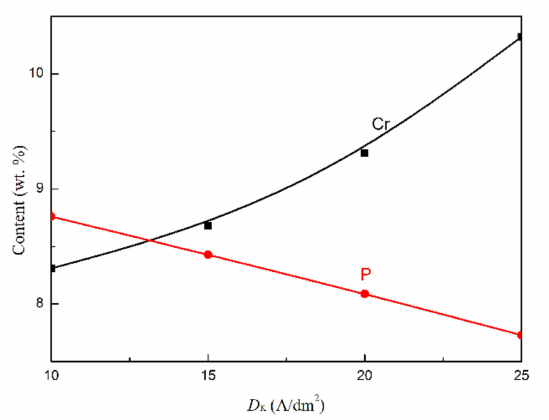
Figure 5. SEM images of the NiCrP alloy coatings at T = 30 ◦ C, pH = 3.5, and 100 g / L of CrCl 3 · 6H 2 O with di ff erent D K : ( a ) 10, ( b ) 15, ( c ) 20, and ( d ) 25.